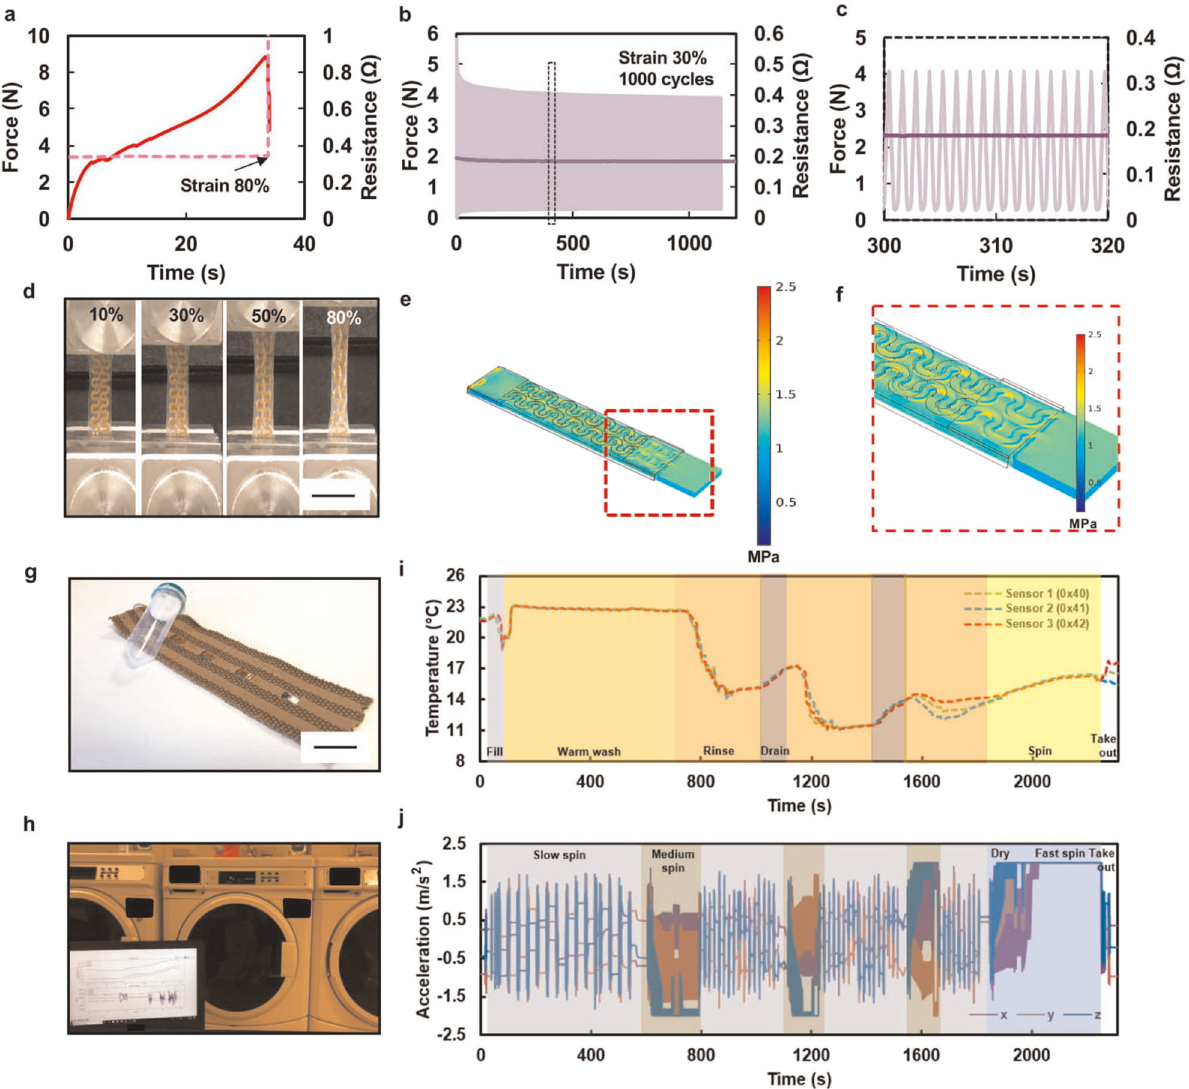
Fig. 4 Electrical, mechanical testing, and modeling of interconnects. a Instron result of a single uniaxial stretching test until rupture. b Time response and its ( c ) magni fi ed view of fatigue cyclic test with a strain of 30%. d Image of serpentine interconnects throughout various strain value (scale bar: 2 cm), e FEM stress distribution of a serpentine interconnect, and ( f ) Zoomed-in views of stress distribution in ( e ). Real-time washing test. g Photograph of the sensorized fabric connected to a BLE system in a sealed, fl oating chamber (scale bar: 3 cm). h Photograph of test setup image. i Graph of temperature and ( j ) accelerometer data during the entire washing